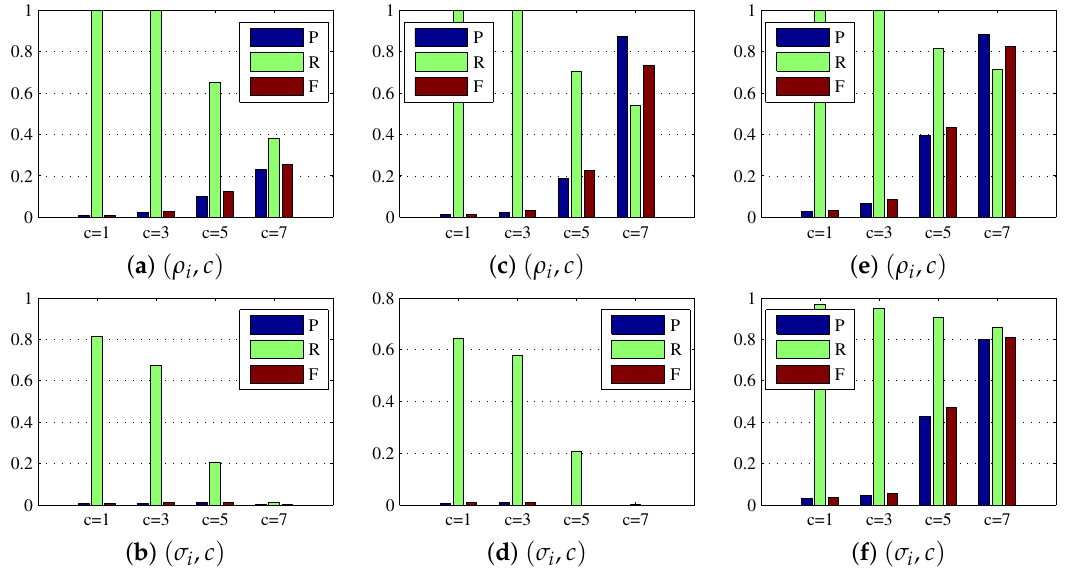
Figure 4. Precision, recall, and F-measure bars for the dense reconstruction maps under different combinations ( ρ i , c ) and ( σ i , c ). ( a , b ) denote the results on Sequence 1, ( c , d ) denote the results on Sequence 2, and ( e , f ) denote the results on Sequence 3.